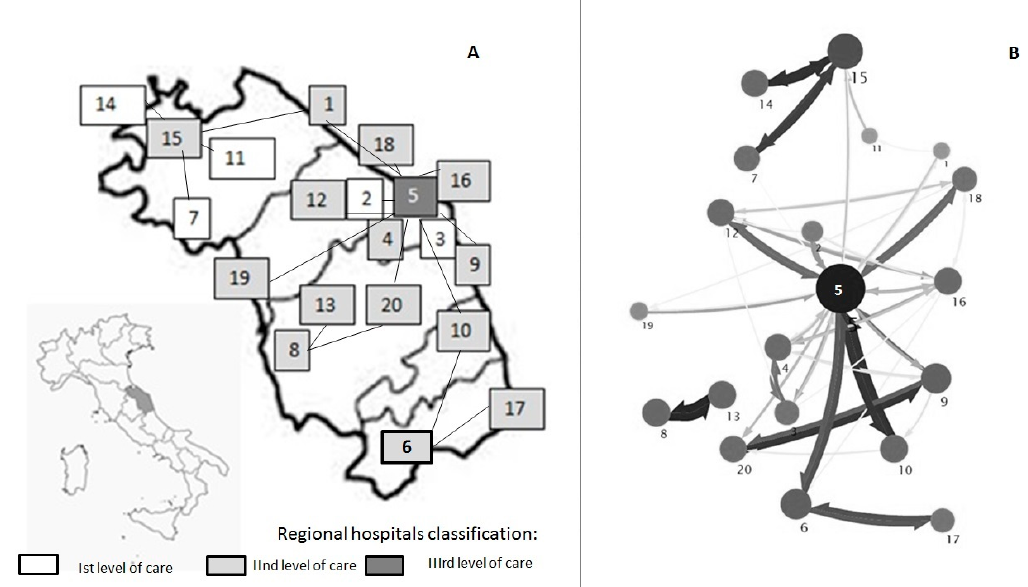
Figure 1. Distribution of hospitals according to level of care, and reciprocal hub-and-spoke connections ( A ), and mapping of inter-facility transfer of CRKP isolates within the Marches hospital network ( B ). (Marches region, Italy, 2014). Each hospital structure is represented by a grey circle. The diameter of the circle is proportional to the amount of MDROs exchanged. The color intensity and the size of the arrows represents the number of CRKP exchanged between hospitals. The direction of the arrows represents the direction of the exchanges. The map has been realized using the Mapequation software